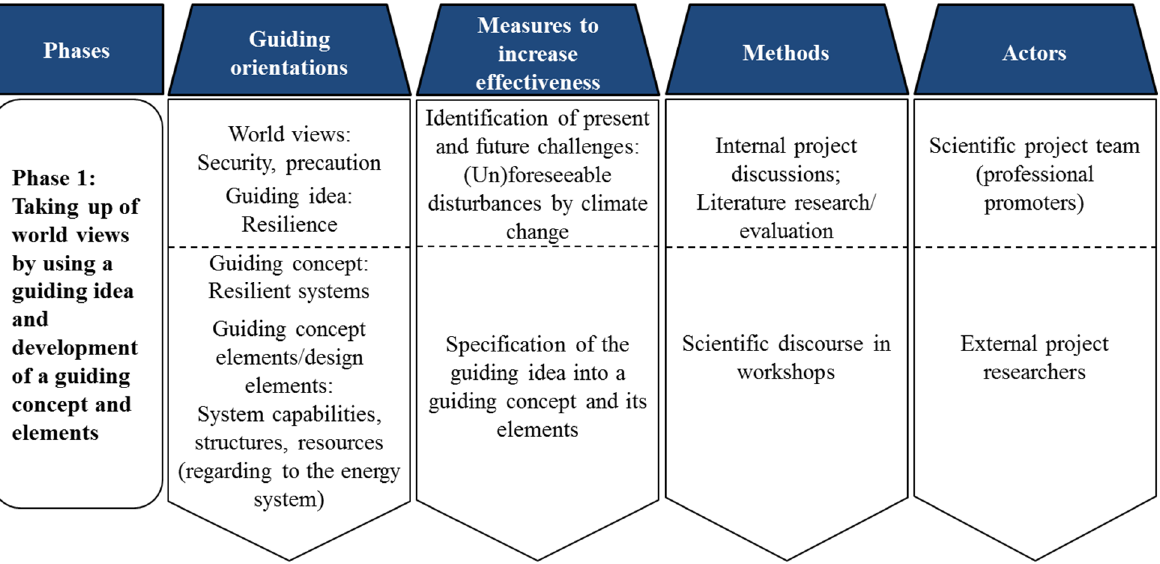
Figure 3. Phase 1 of the regional guiding orientation